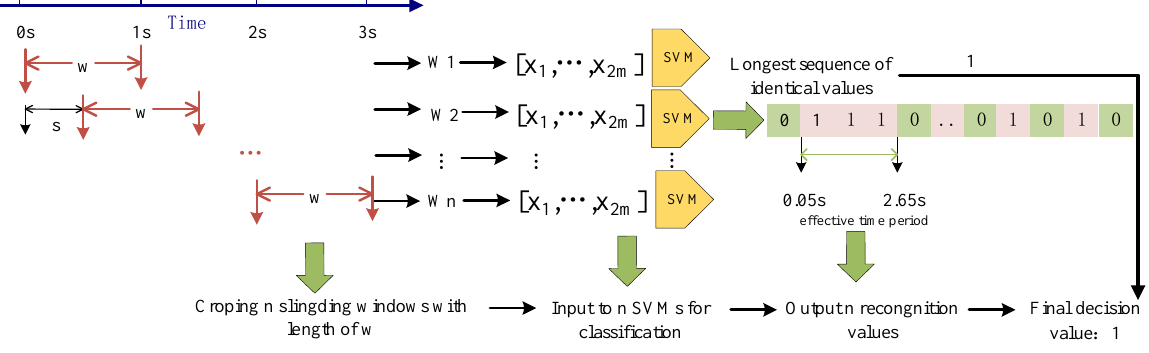
Figure 5. Schematic diagram of the ED decision algorithm.